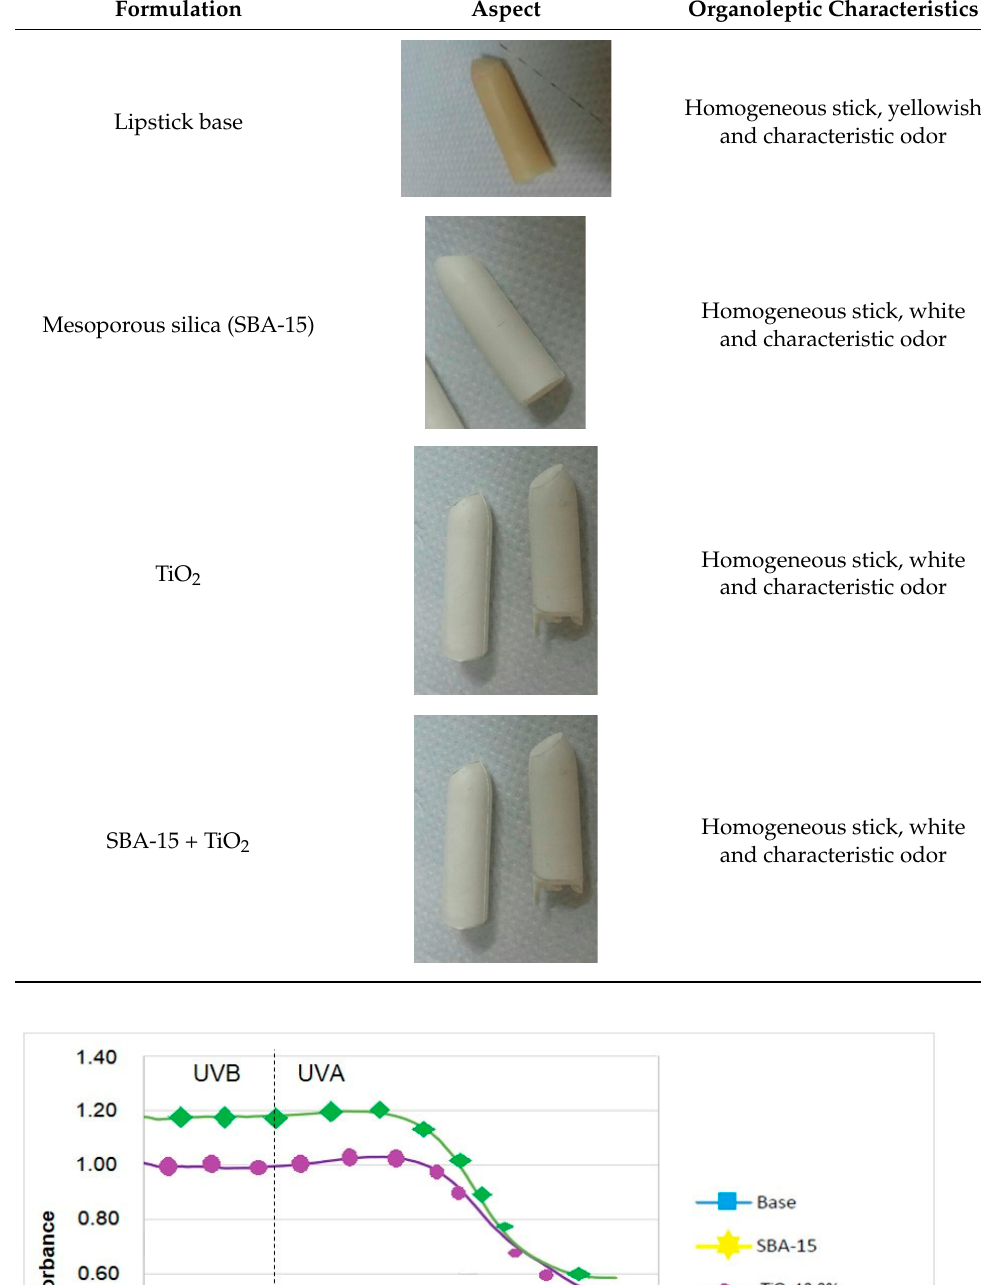
Table 2. Aspect and organoleptic properties of the lipstick samples.